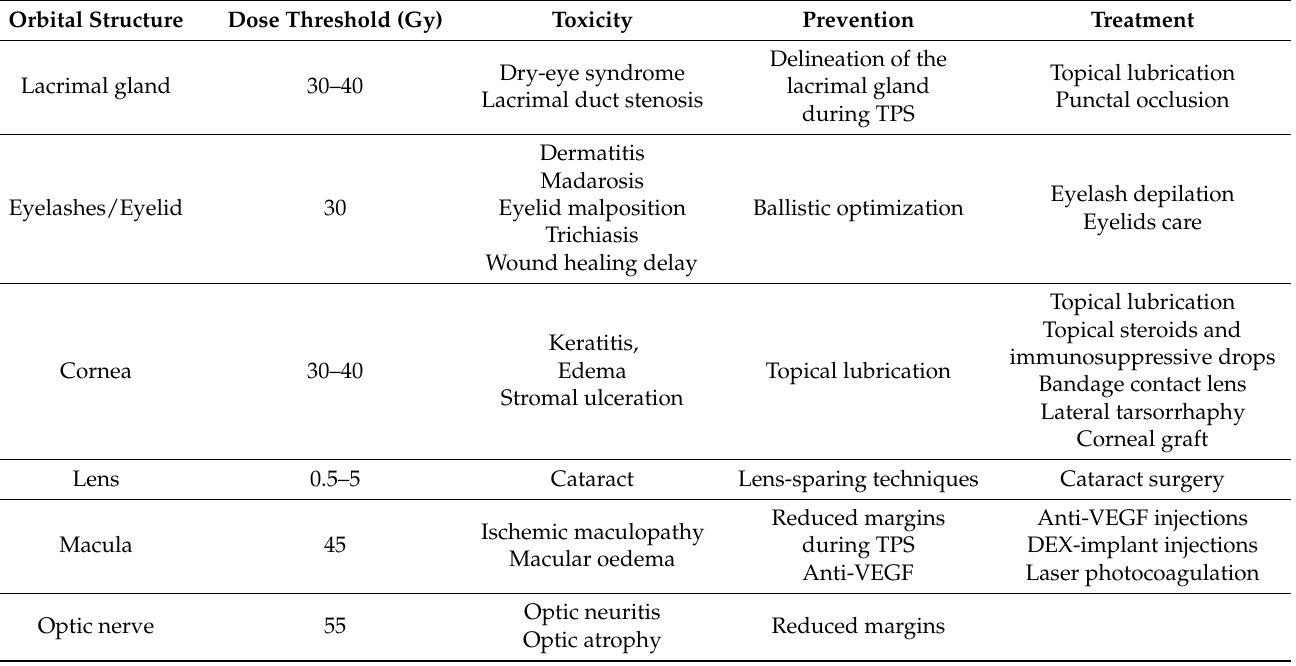
Table 1. Summary of the radiation toxicity of several critical intraorbital